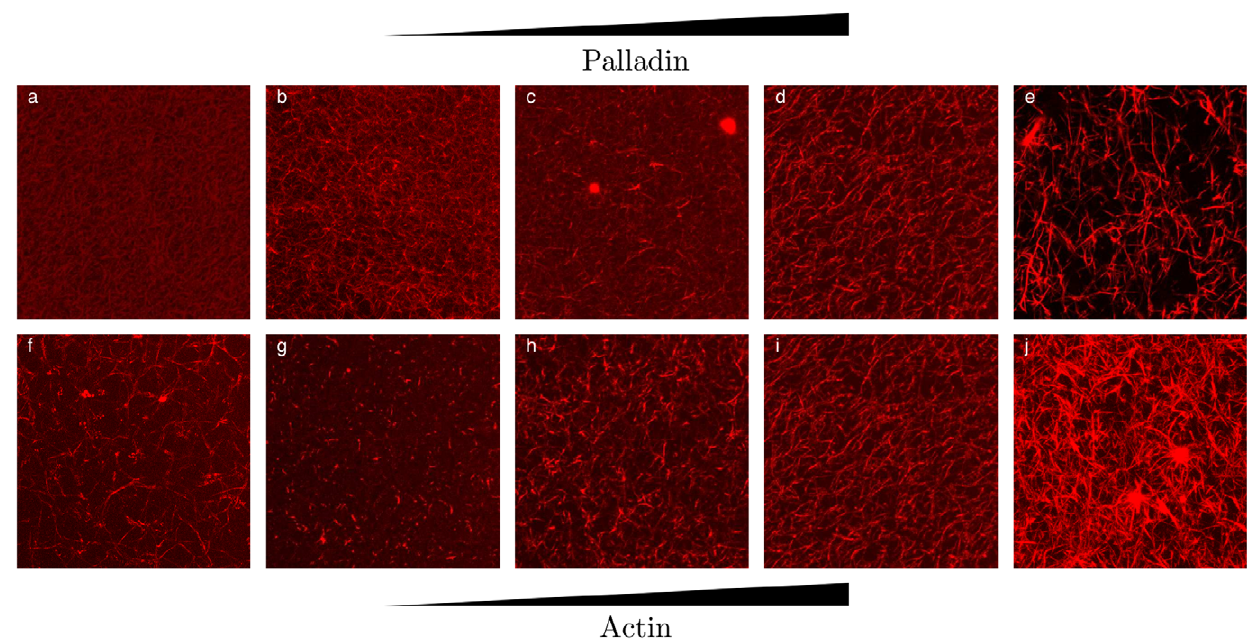
Figure 1. Palladin forms bundled actin networks. (a)–(e): Maximum intensity projections of confocal stacks of actin networks ( c a ~ 10 m M) with palladin R pa ~ 0 : 007,0 : 018,0 : 035,0 : 07 and 0 : 12 respectively. (f)–(j): Maximum intensity projections of confocal stacks of actin networks with fixed R pa ~ 0 : 07 and varying actin concentrations ( c a ~ 1 m M,2 m M, 5 m M, 10 m M, 20 m M respectively). Images are 72 m m per side.